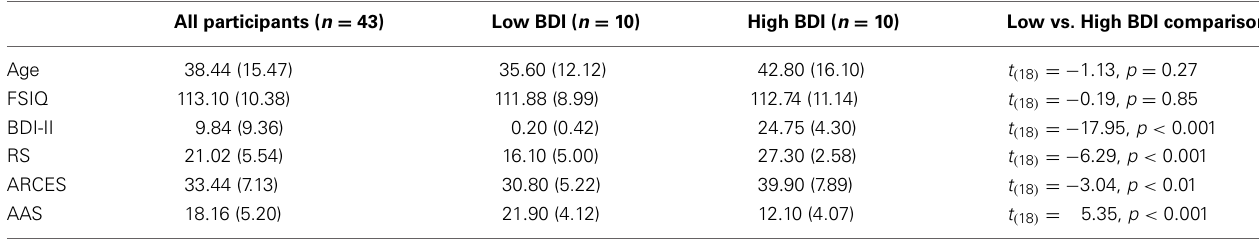
Table 1 | Demographic characteristics and mood measure data for study